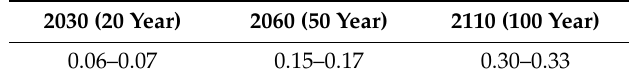
Table 5. Predicted sea level rise along the Weifang coast since the year of 2010 (unit: m).